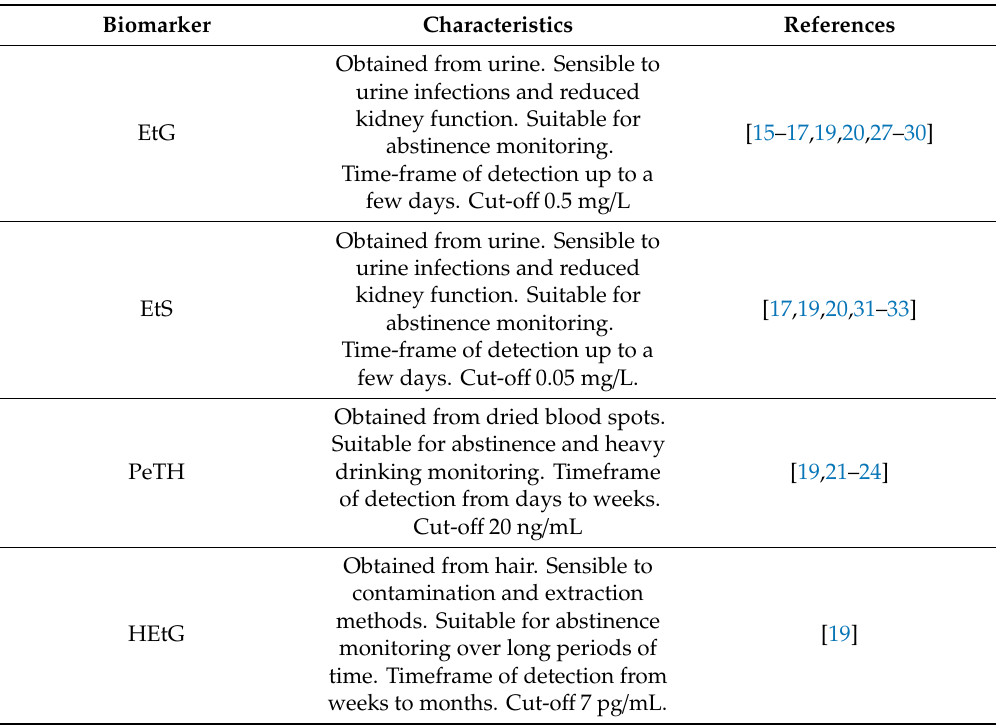
Table 2. Main characteristics of the study biomarkers. Biomarker